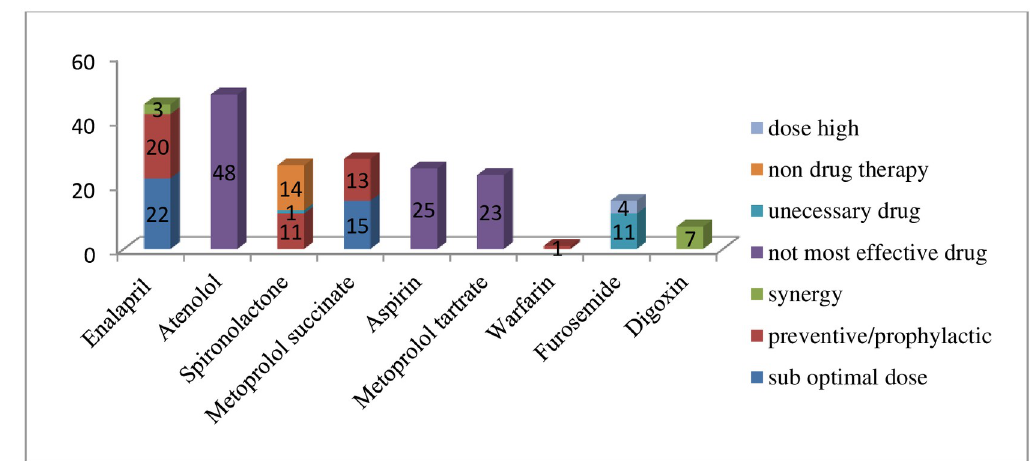
Fig 3. Drug classes involved in specific type of drug therapy problems among heart failure patients attending at the cardiac clinic of Tikur Anbessa Specialized Hospital, Addis Ababa, Ethiopia June—August, 2017.